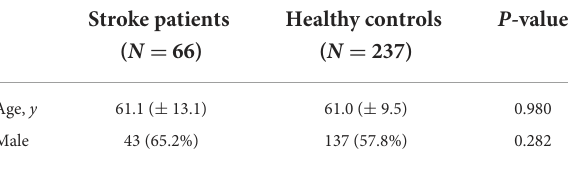
TABLE 1 Analysis of baseline characteristics of the stroke patient and healthy control